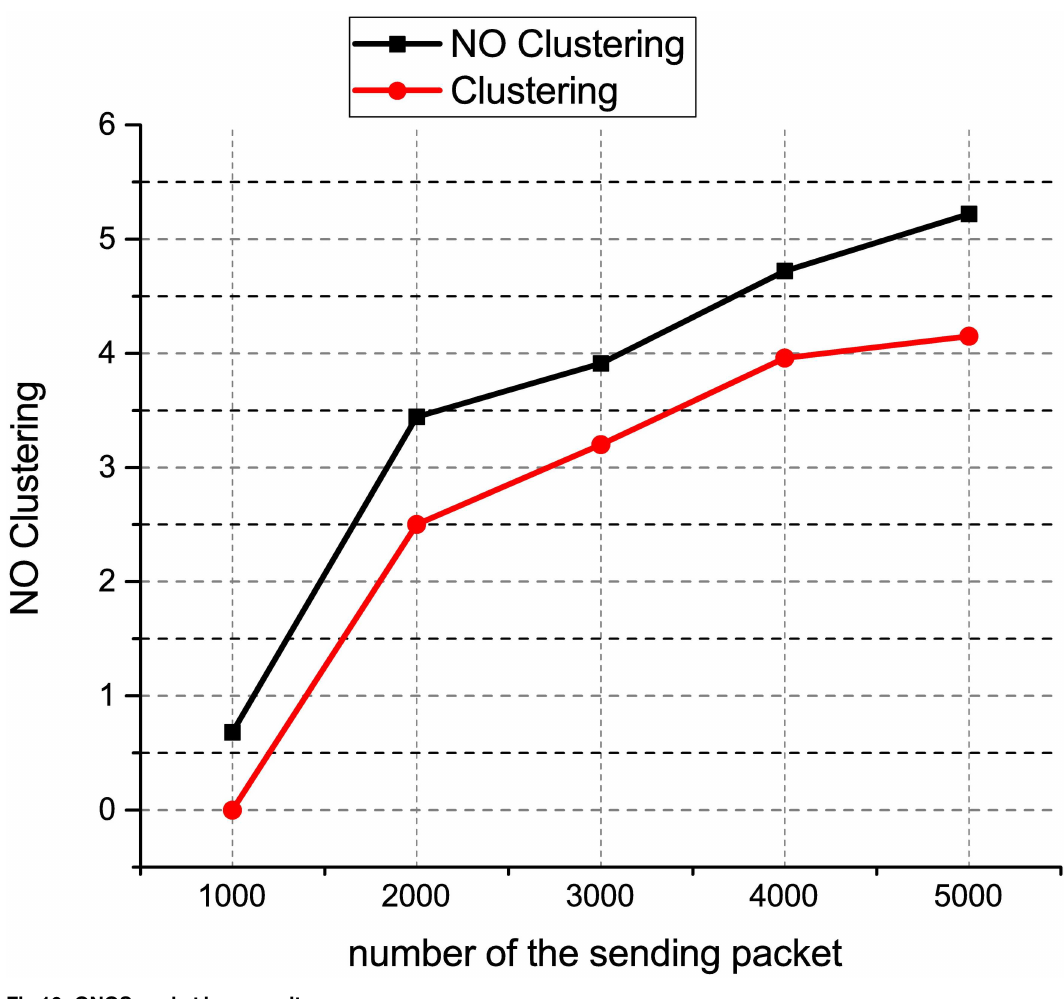
Fig 10. ONOS packet loss